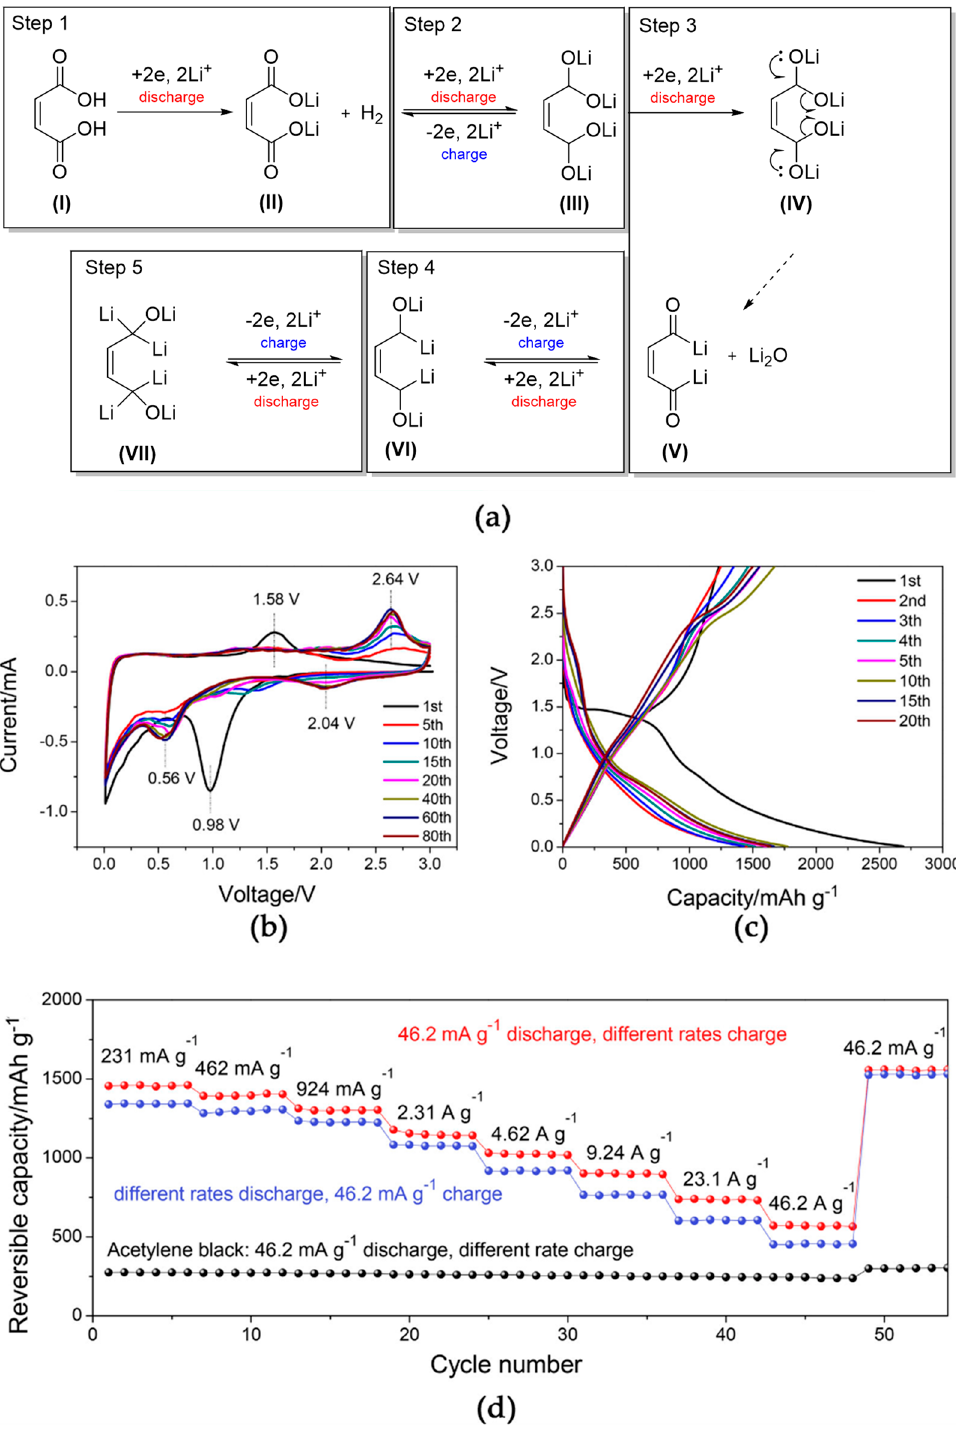
Figure 8. ( a ) Structure & proposed lithiation mechanism of the maleic acid as an anode; ( b ) cyclic voltammograms and ( c ) voltage profiles and charge and discharge profiles at 46.2 mA g –1 in the voltage range of 0.01–3.0 V; ( d ) rate capability at room temperature (red and blue line correspond to charge and discharge, respectively). Adapted from [110] .